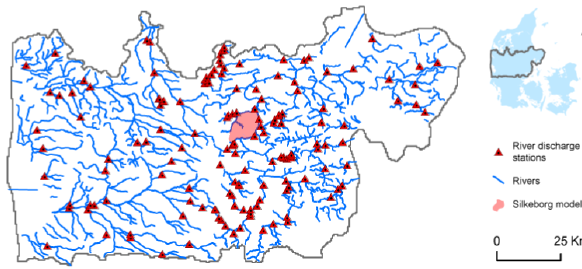
Fig. 3. Set-up of nested model approach with the regional DK- model Area 5.